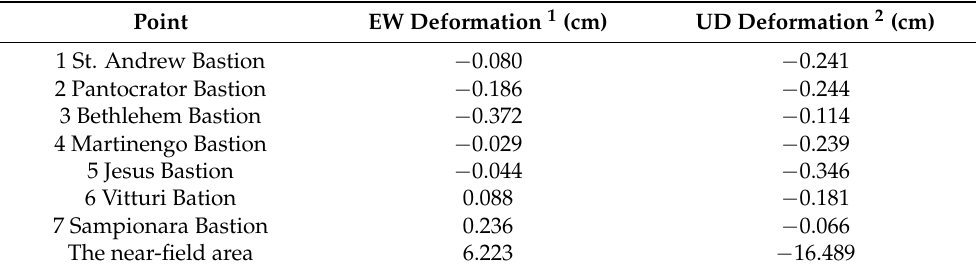
Figure 6. Two-dimensional co-seismic deformation field. The red star means the location of the epicenter. ( a ) EW deformation, positive to the east; ( b ) UD deformation, positive uplift. Table 3. The co-seismic 2D deformations of the 7 bastions of the HCW and the near-field area of the Mw 5.9